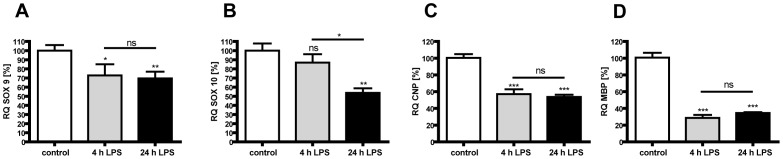
LPS activated microglia decrease oligodendrocyte development and maturation.For evaluation of disturbed oligodendrocyte maturation in vitro we did gene expression analysis of co-cultures after 4 and 24 h of LPS-stimulation using quantitative Real-Time PCR. Sox9 (A), CNP (C) and MPB (D) gene expression is reduced after 4 h (grey bar) and remains at low levels at 24 h (black bar), whereas SOX10 (B) gene expression is only slightly reduced after 4 h (grey bar) but further decreases at 24 h (black bar). Experiments were performed three times in duplicates. * p<0.05, ** p<0.01, *** p<0.001 and ns for p>0.05; VN: vehicle+normoxia, LN: LPS+normoxia, VH: vehicle+hyperoxia, LH: LPS+hyperoxia.